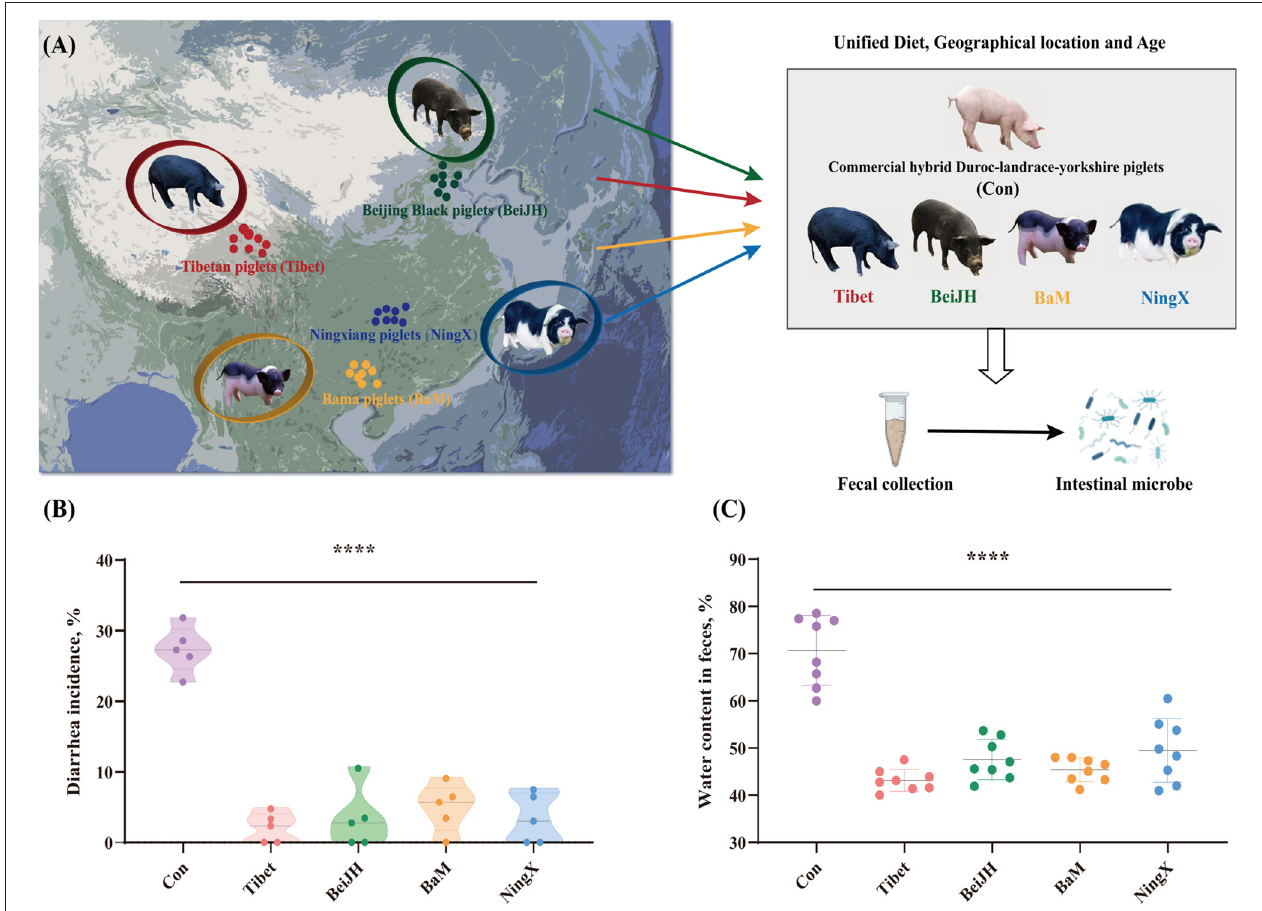
FIGURE 1 | Native Chinese breeds showed stronger diarrhea resistance than commercial hybrid piglets. (A) The geographic location of the original population of four Chinese native pig breeds on the map, and the schematic diagram of the project process. (B) Chinese native pig breeds exhibited a significantly reduced diarrhea rate than commercial hybrid piglets. (C) Chinese native pig breeds showed reduced water content in feces. **** P <